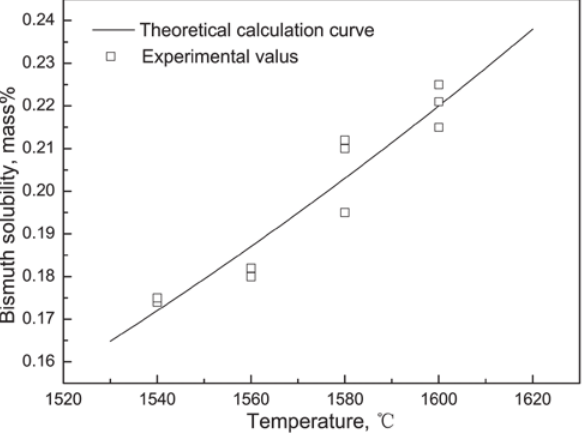
Fig. 4: Bismuth solubility as a function of temperature in liquid Bi-S steel under a constant